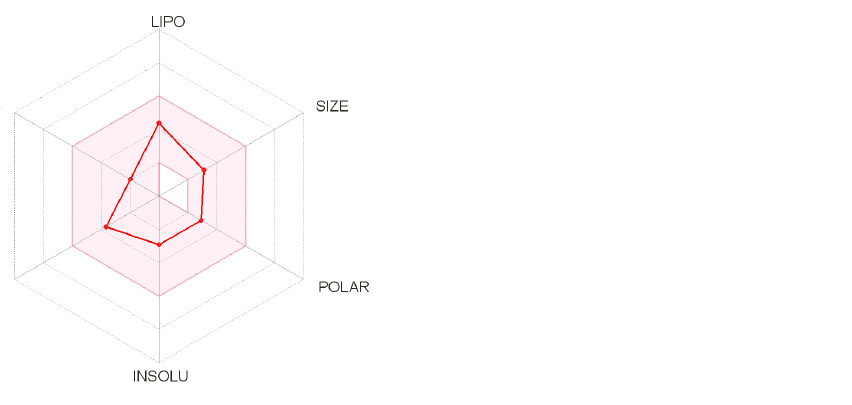
Figure 23. Bioavailability radars for compound 1. Pink zone—lipophilicity (LIPO) values are within the range − 0.7 < XlogP3 < +5.0; molecular weight (SIZE) values are 150 g/mol < MW < 500 g/mol; polarity (POLAR) values are 20 Å² < TPSA < 130 Å²; insolubility (INSOLU) values are 0 < logS < 6; insaturation (INSATU) values are 0.25 < Fraction Csp3 < 1; flexibility (FLEX) values are 0 < Num. rotatable bonds < 9.